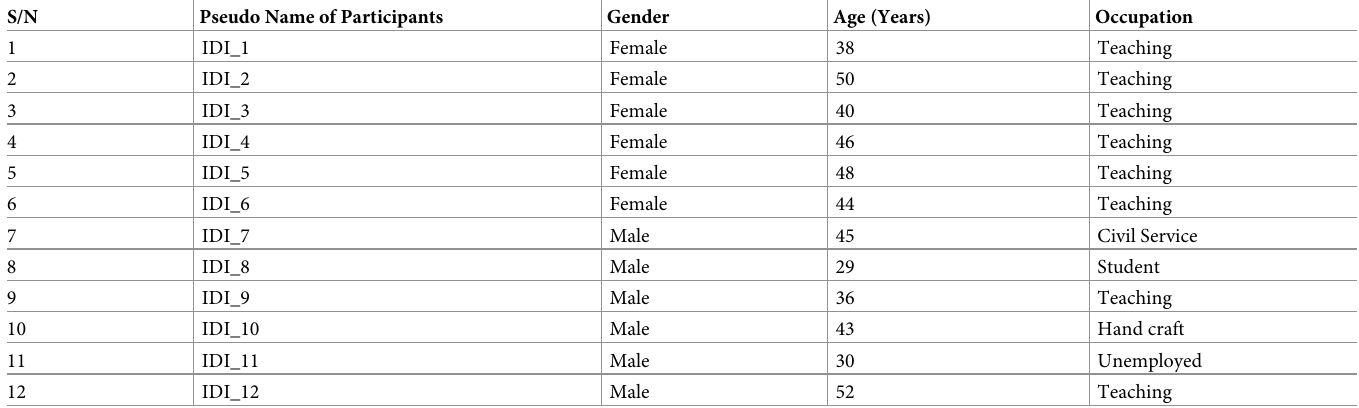
Table 1. Metadata of in-depth interview participants.